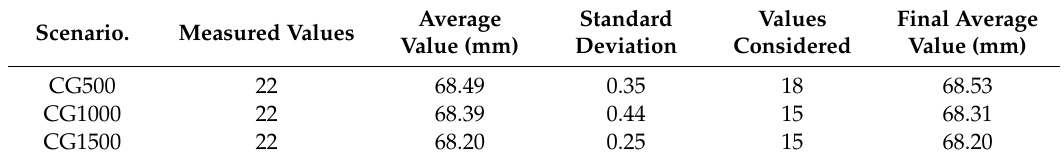
Table 2. Centralization of measurements for the central rubber band width.